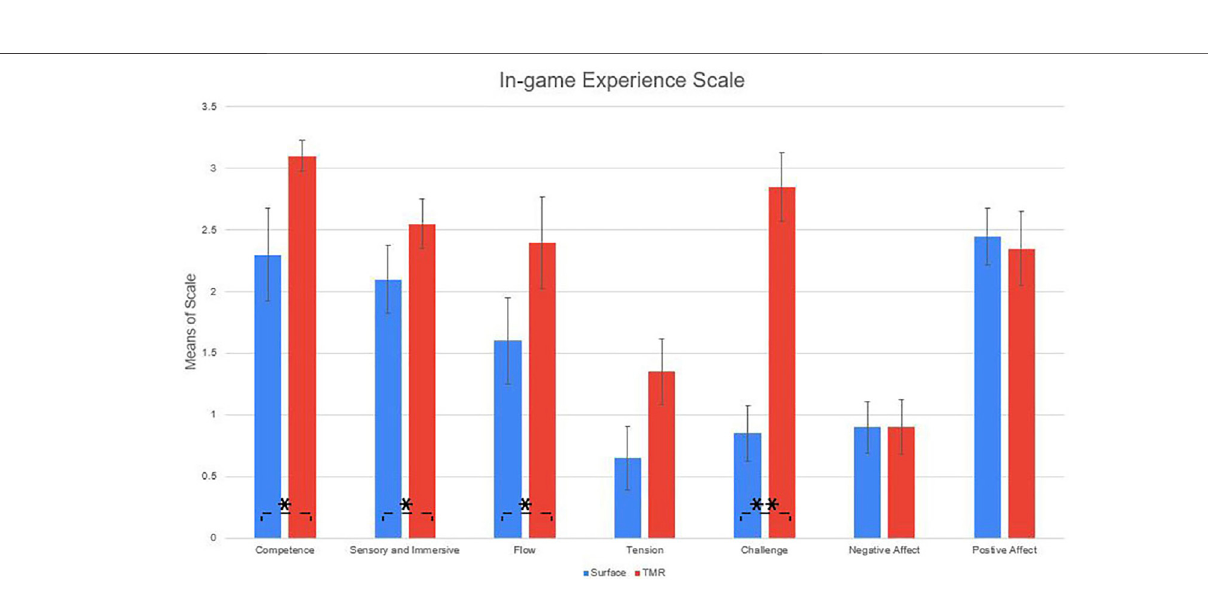
Frontiers in Virtual Reality |